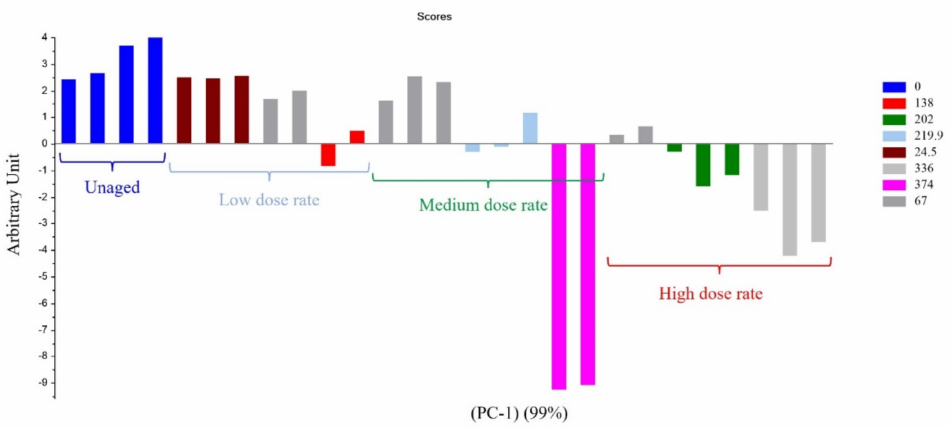
Figure 3. PC1 results on Mod2: first irradiation doses (kGy) classified as a function of dose